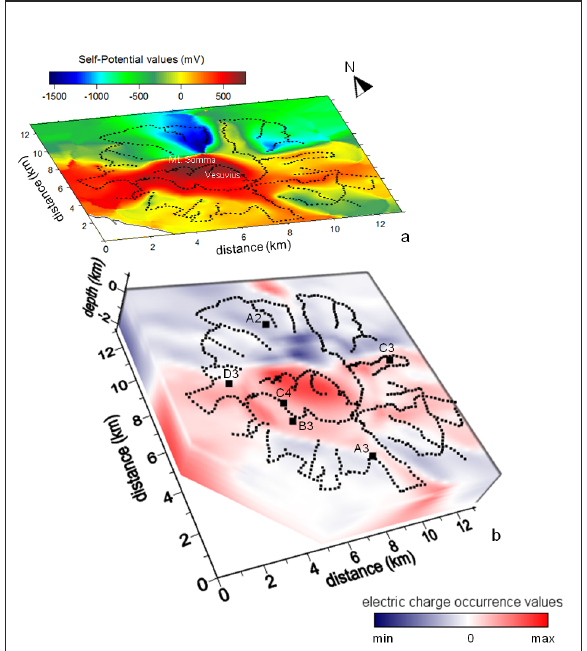
Figure 10. Results of the self-potential survey performed in the Mt. Somma-Vesuvius area along the circuits shown in Figure 1b. (a) SP anomaly map, redrawn after Di Maio et al. [1998]. (b) Volumetric view of the 3D inversion of the SP data shown in (a). The volume data are reported with a clipping plane that allows to visualize a section par- allel to the SP survey area of Figure 1b at a depth of about 150 m above sea level. The black rectangles indicate the location of the shot